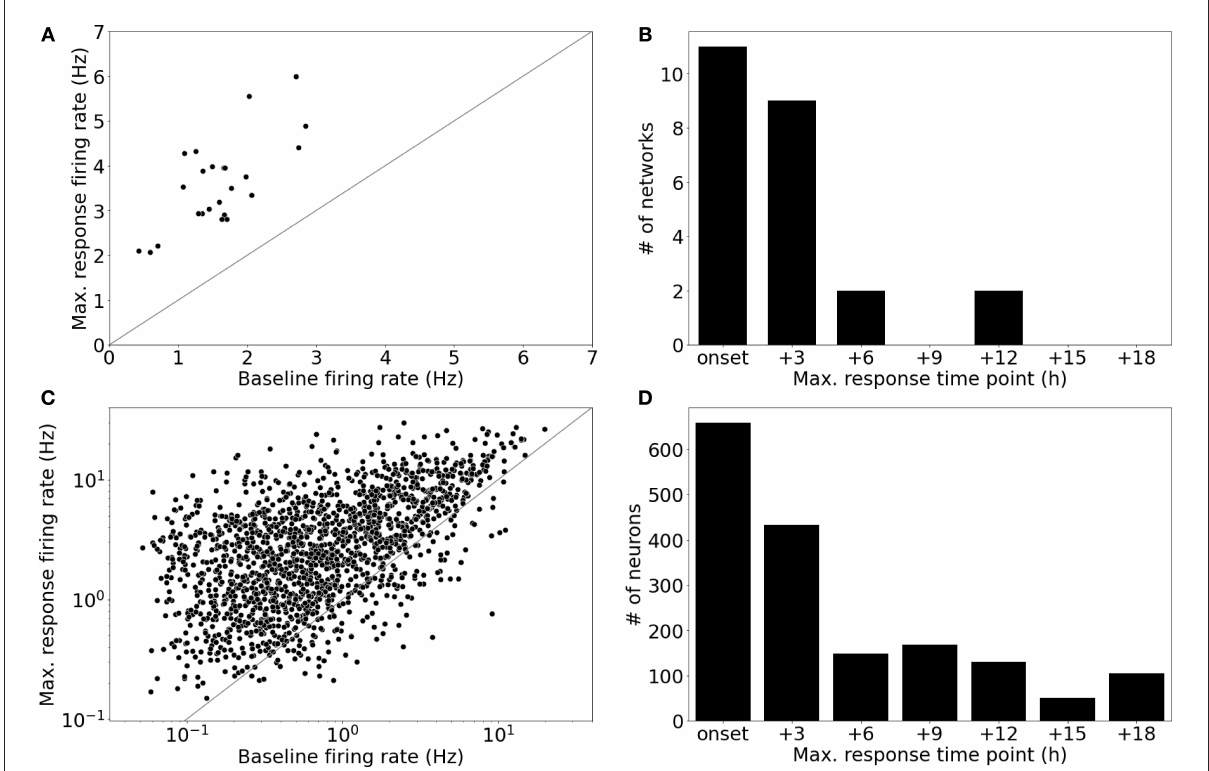
FIGURE4 Single-neurons showed highly variable firing rate responses to Bicuculline perturbation. (A) All networks showed an increase in their population firing rate in response to Bicuculline (BIC, 5 µ M). The increase was measured in fold-change, 1 fch [2.450 ± 0.827 ( µ ± σ )]. (B) The majority of networks ( n = 20/24) showed maximum firing rates within the first two time points after the perturbation (BIC, 5 µ M), while four networks showed maximum responses at later time points. (C) The pooled analysis of all neurons in the networks revealed that there was a subset of neurons ( n = 146/1,695) that decreased their firing rates, while the network to which they belonged showed an increased firing rate. The differential fold-change, 1 fch ′ , measured for each neuron showed a mean value of 5.9 ± 10.6 ( µ ± σ ). (D) Peaks in the firing rate responses were distributed over the entire perturbation time window. The neurons showed peaks in their firing rates even at time points where no network featured a peak in the firing rate.